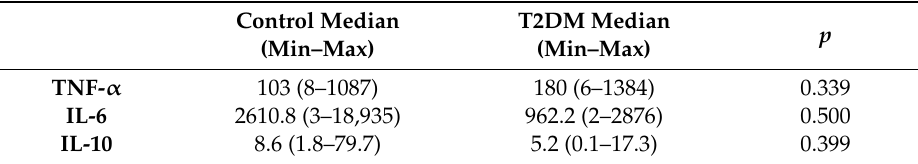
Table 3. Cytokine production with butyrate treatment.